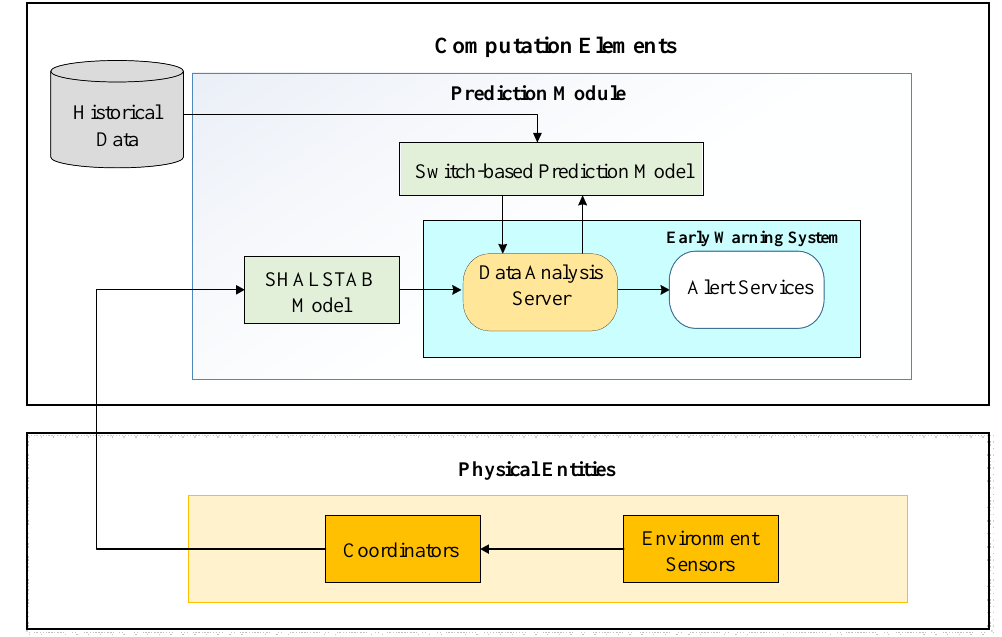
Figure 1. Model switched landslide prediction system